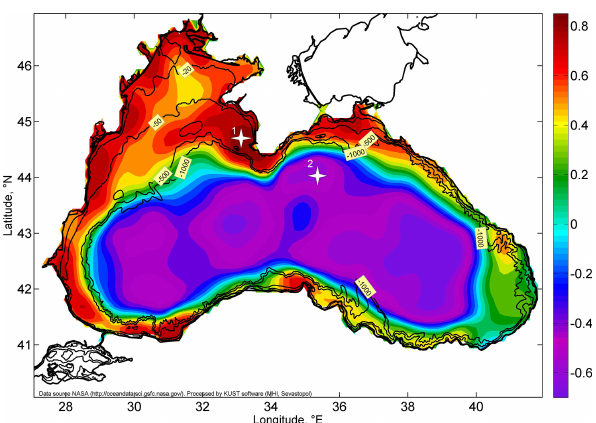
Figure 3. Correlation coefficients between the basin-averaged wind curl and DSL for the time series smoothed with a 365-day mov- ing average (only interannual signals are retained). Solid black lines show isobaths (20, 50, 500, and